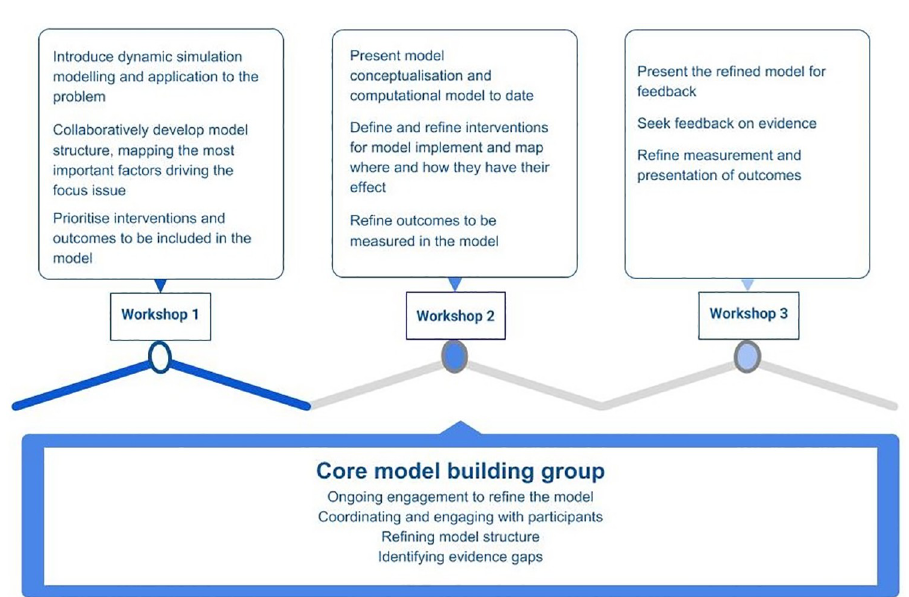
Fig 1. Overview of activities involved in the participatory